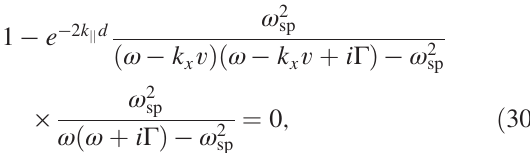
FIG. 4. Two silver semispaces separated by d ¼ 10 nm ( ω oscillation frequencies of two “ twin ” natural modes (black lines and green lines) as a function of the normalized k v ¼ 2 ω d . The transverse wave number is normalized to k 0 sp frequencies as a function of the normalized collision frequency Γ of silver for k Imaginary part of the natural oscillation frequencies as a function of the relative velocity for k 0 , the solid lines represent the nonrelativistic calculation, and the dashed lines represent the exact relativistic plots, k y ¼